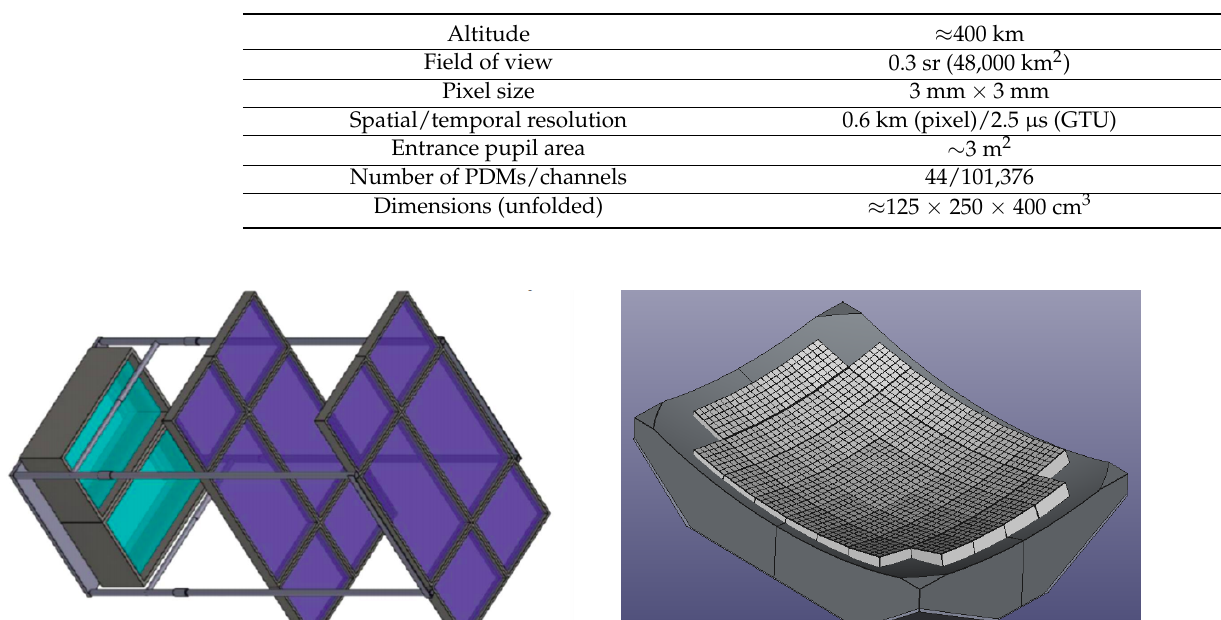
Table 1. Technical parameters of K-EUSO.